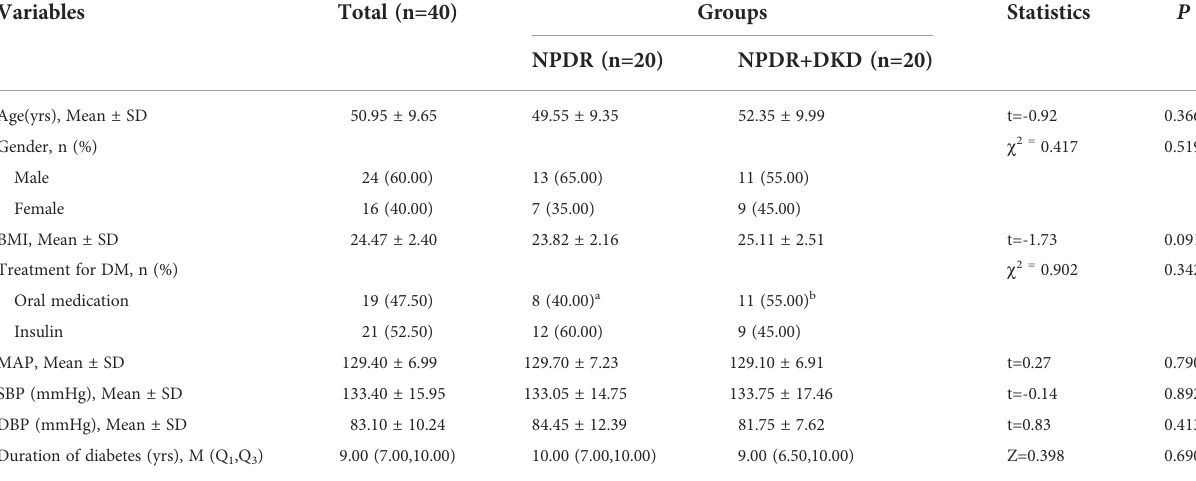
TABLE 3 Characteristics of NPDR and NPDR+DKD patients for plasma collection and